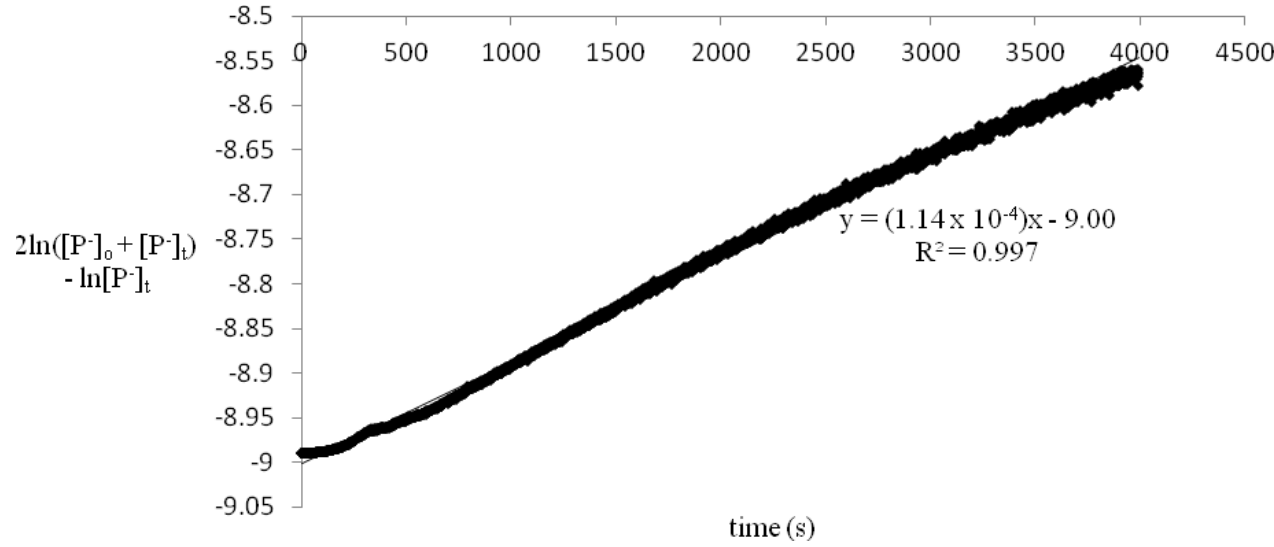
Figure 2. 2ln([P − ] picrate with 1.18 × 10 − 2 M methyl